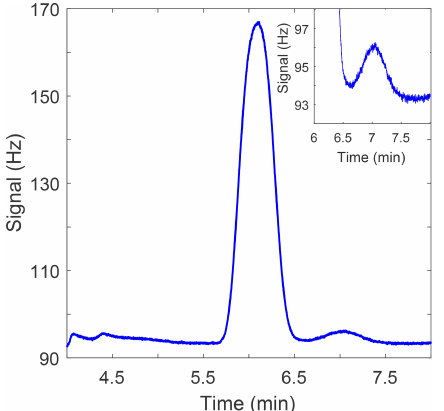
Figure 2. Sample chromatogram showing N 2 O peak at a retention time of 6.1min and the SF 6 peak at a retention time of 7.0min. The inlay in the upper-right corner shows an enlarged plot of the SF 6 peak.